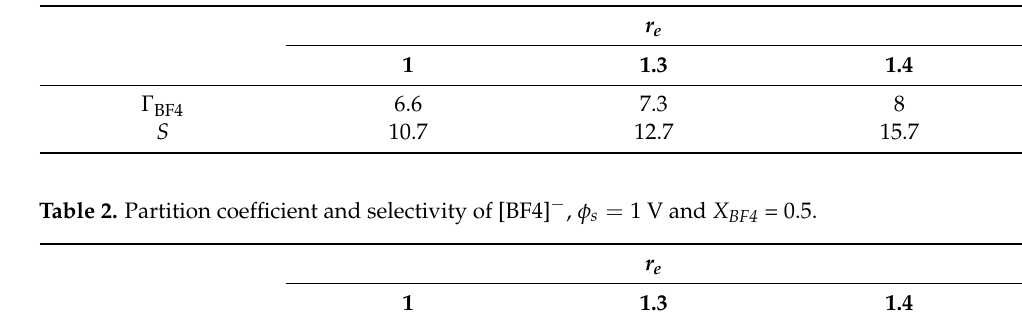
Table 1. Partition coefficient and selectivity of [BF4] − , φ s = 1 V and X BF4 = 0.2.